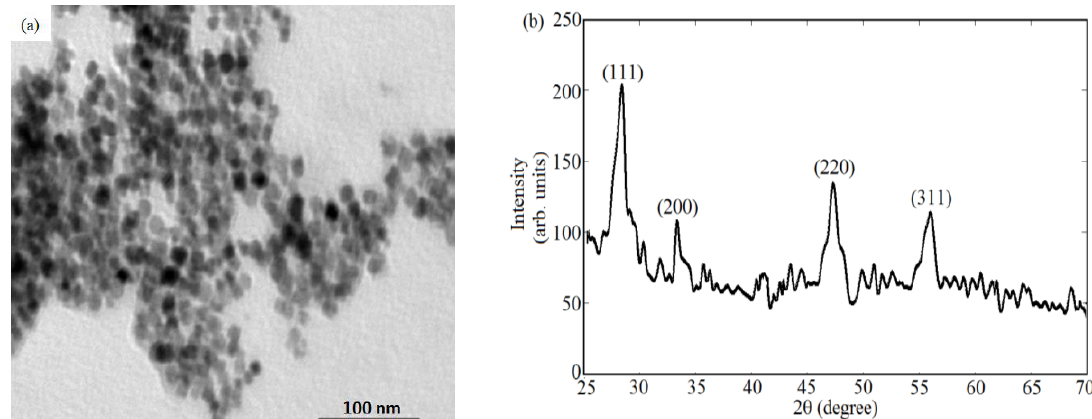
Figure 3. ( a ) TEM image of in-situ added gold-ceria nanoparticles; and ( b ) XRD pattern of gold-ceria nanoparticles.